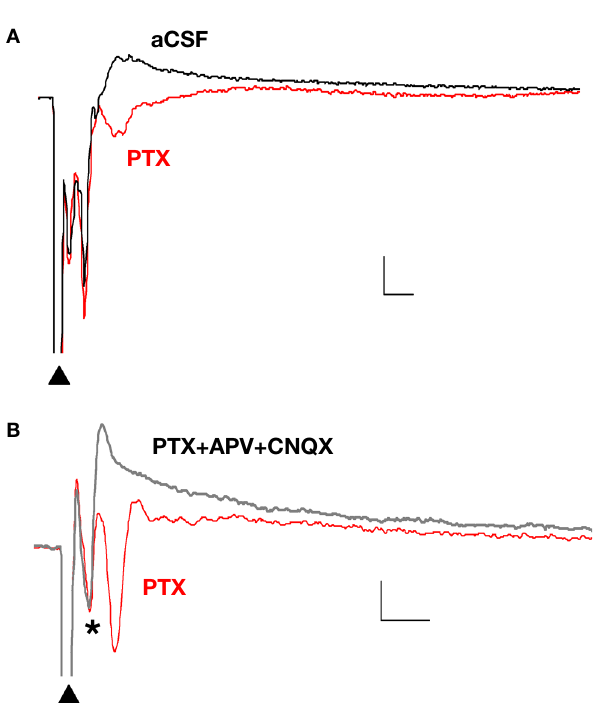
Figure 1 | Polysynaptic activity in the superior lateral amygdala dorsal subnucleus (LAd-s) evoked by thalamic afferent stimulation is revealed by blockade of GABAergic inhibition and is eliminated by glutamatergic antagonism. (A) Example of FP traces from the LAd-s showing effect of PTX (75 μ M). (B) Example of FP traces in LAd-s depicting effect of glutamatergic antagonism (10 μ M CNQX + 100 μ M APV). Only the presynaptic fi ber volley (FV, * ) remains. Scale = 0.1 mV, 10